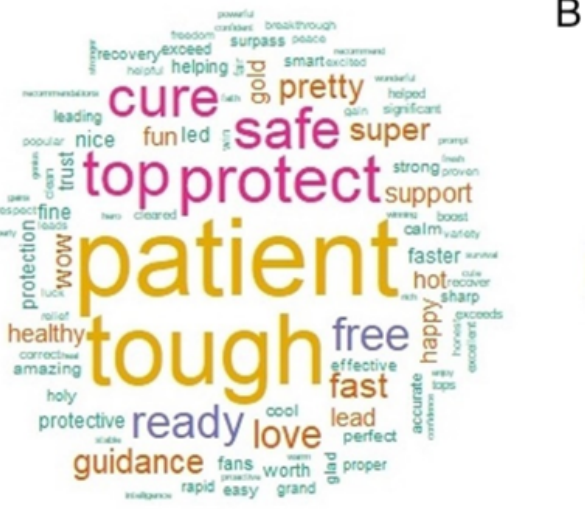
Figure 9. Word clouds of frequent positive (A) and negative (B) keywords related to the COVID-19